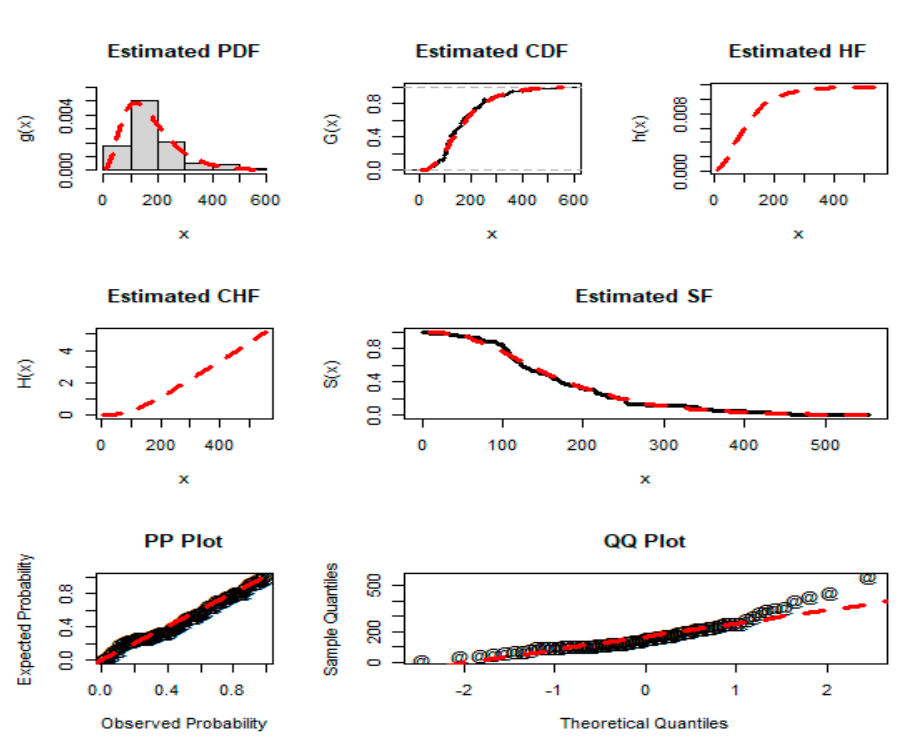
Figure 5. Estimated PDF, CDF, HF, CHF, SF, PP plot, and QQ plot of the NGLog–Weib distribution for dataset 1.